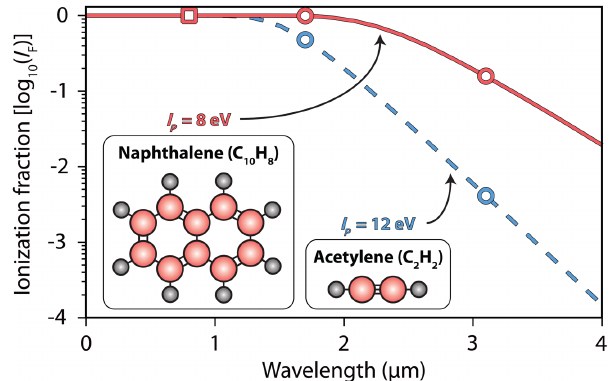
FIG. 3. The quadratic scaling of the maximum return energy with wavelength for an intensity of 1 . 0 × 10 14 W cm − 2 . The red square represents 0 . 8 - μ m radiation while the red circles are the wavelengths of our OPCPA. The inset shows an electron energy distribution, which extends up to 550 eV, that was measured after ionization of C 2 H 2 using the 3 . 1 - μ m